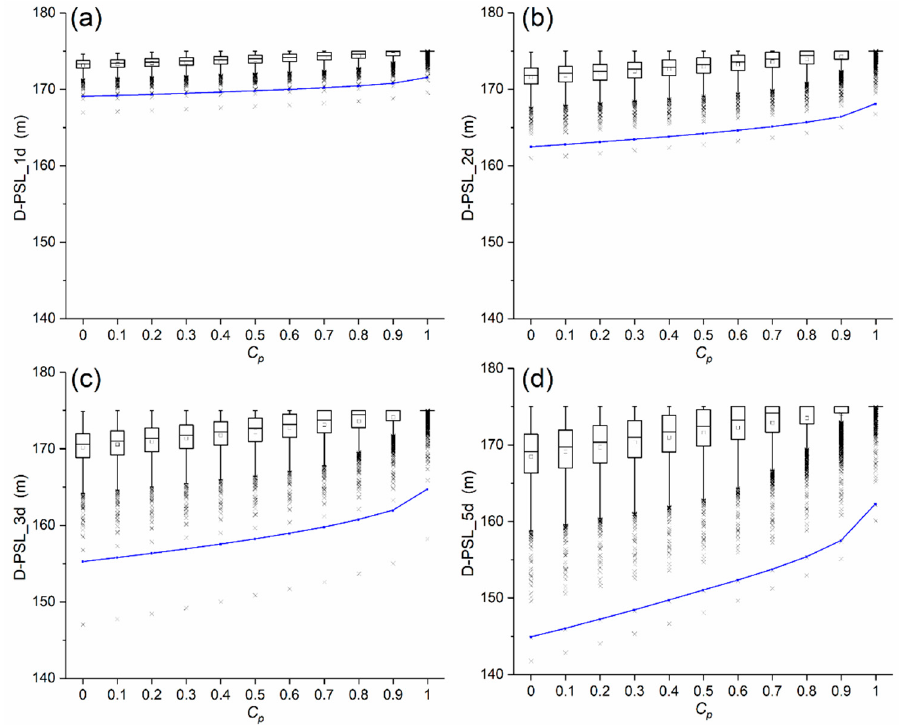
Figure 5. ( a – d ) The D-PSL 1 d , D-PSL 2 d , D-PSL 3 d , and D-PSL 5 d obtained from the forecasted maximum 1 day, 2 day, 3 day, and 5 day flood volumns for the 10,000 simulated floods. The blue line marked the D-PSL ts s obtained from the forecast flood with a 1000 year design return interval, as listed in Table 1, with the change of forecast skill.